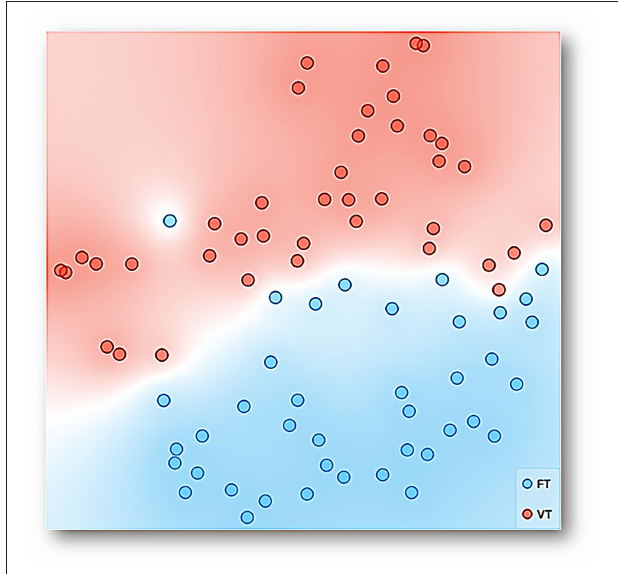
FIGURE 6 | Representation with t-SNE for the data of all experimental sessions and subjects. Each point represents multidimensional data for a session, considering the distance traveled, entropy, divergence, maximum velocity, coincidence index, mean distance to the dispenser, and session number into the experiment as dimensions with time-based schedule, FT and VT, as a target feature. The data with similar values given the multiple features or input variables taken as a whole is simply closer to each other than data with dissimilar